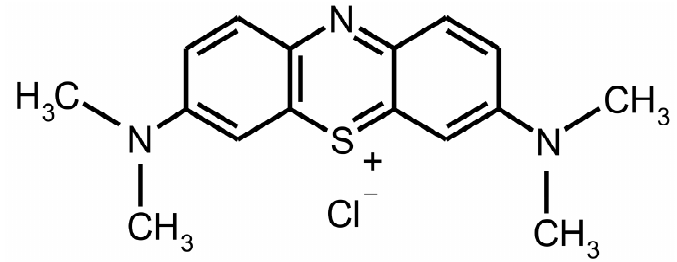
Figure 1. Chemical structure of methylene blue [9].